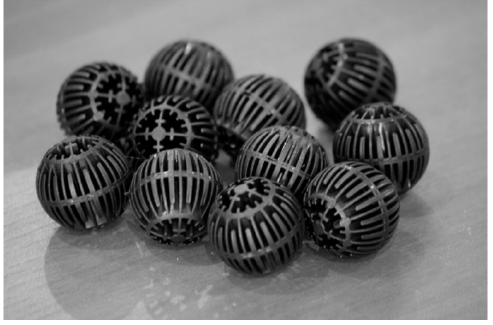
Figure 6. Floating carrier Bioballs.